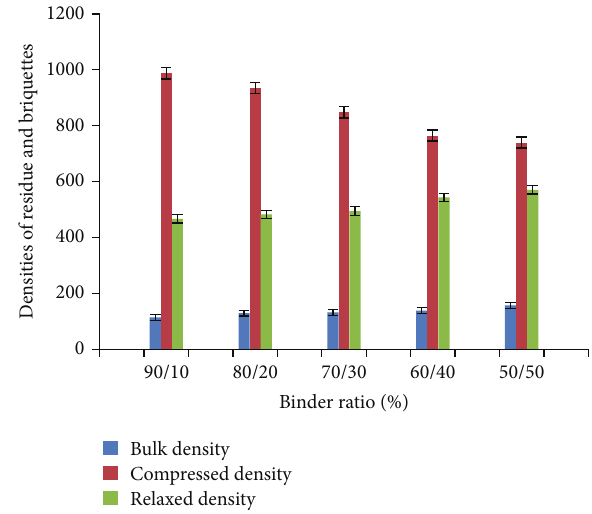
Figure 1: Densities of water hyacinth residue and